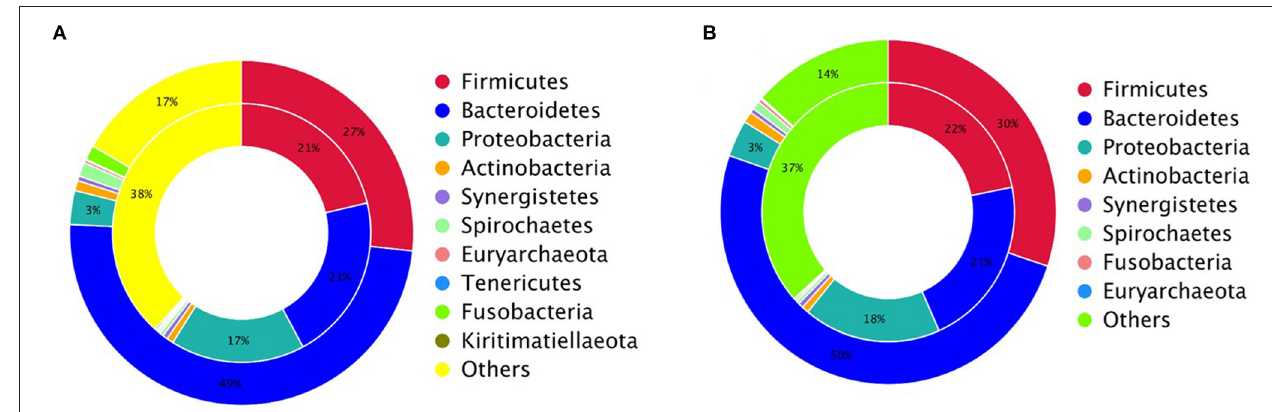
FIGURE 5 | Analysis of unique antibiotic-resistant bacteria in Japanese quail ( Coturnix japonica ): (A) predominant bacterial hosts of antibiotic-resistance genes (ARGs) in the female quail; (B) predominant bacterial ARG hosts in the male quail.